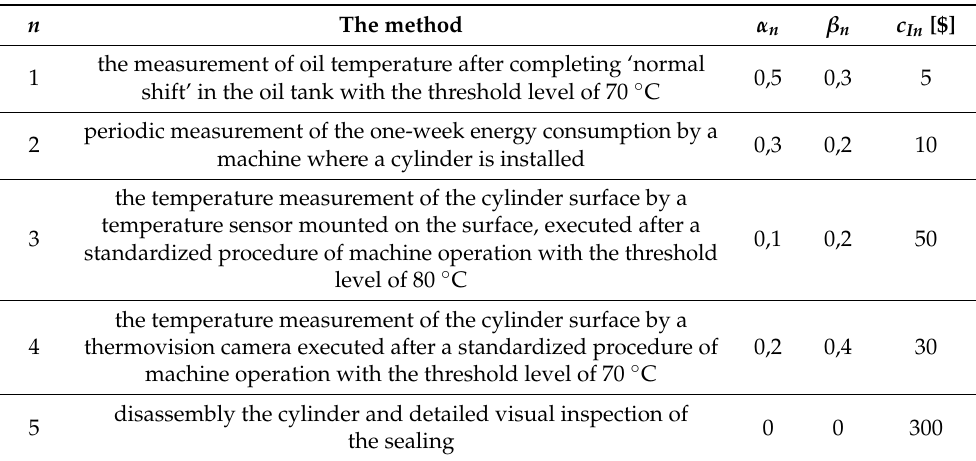
Table 2. Probability and cost parameters of the available inspection